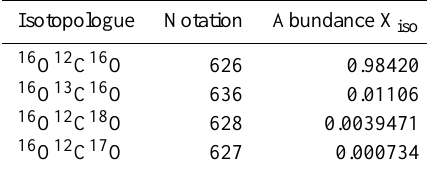
Table 3. HITRAN isotopologue natural abundances.